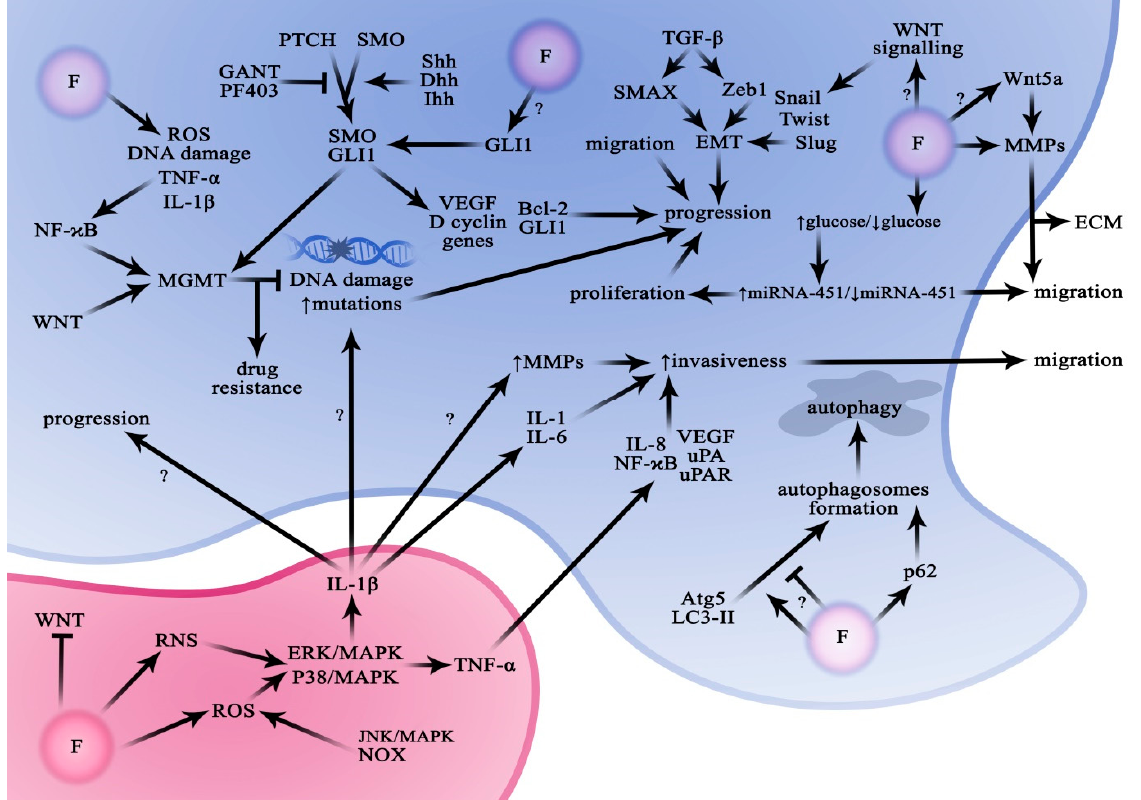
Figure 3. Effect of fluoride on signalling pathways in glioma cells. Although the data currently available is incomplete on many issues, it appears that fluoride may affect signalling pathways involved in the processes of apoptosis, autophagy, inflammation, and chemoresistance of glioblastoma cells. Thus, this compound has the potential to promote the growth and invasiveness of